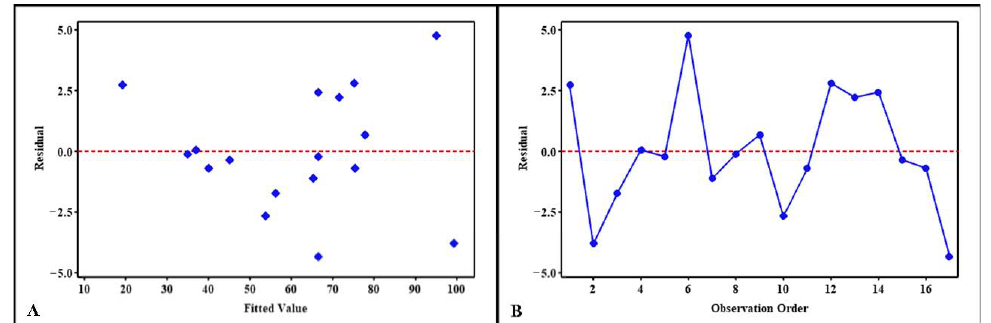
Figure 6. Residual plots: Residuals versus ( A ) predicted values and ( B ) their order. Catalysts 2020 , 10 , x FOR PEER REVIEW